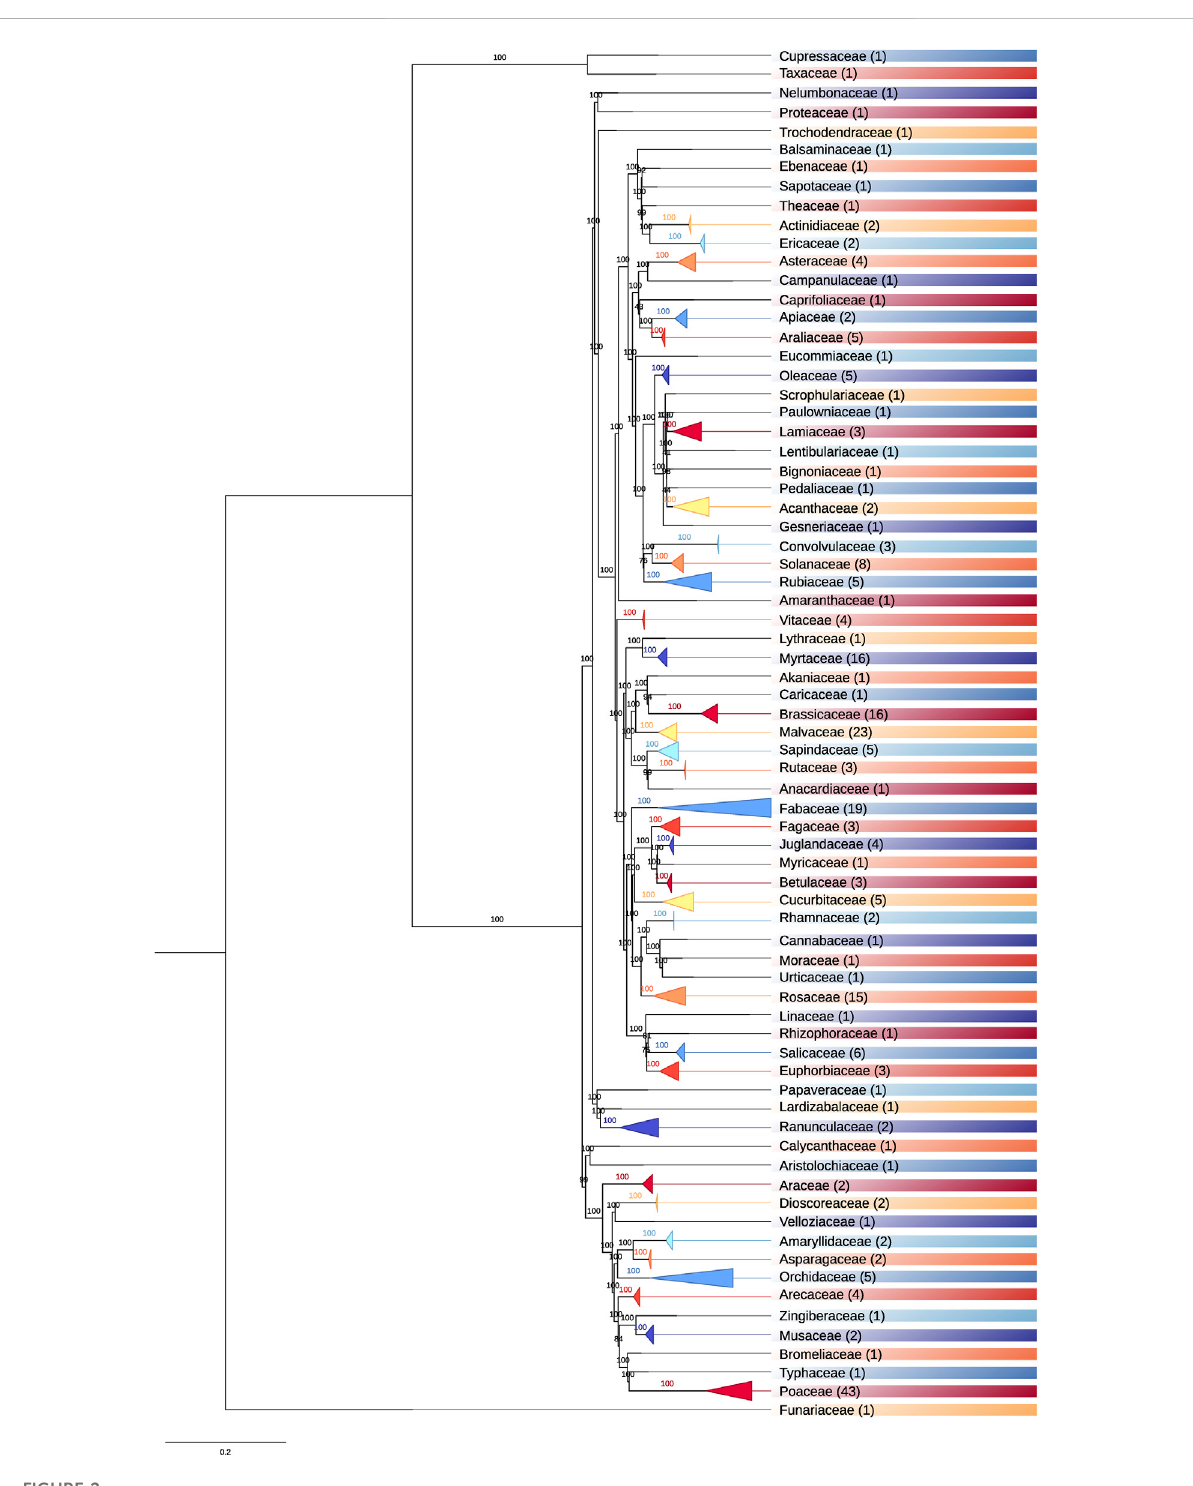
FIGURE 2 Plastome-based phylogenomic tree for 270 plant species with complete nuclear genomes deposited on NCBI. The number of species a family comprises is given in parentheses. The colors indicate different